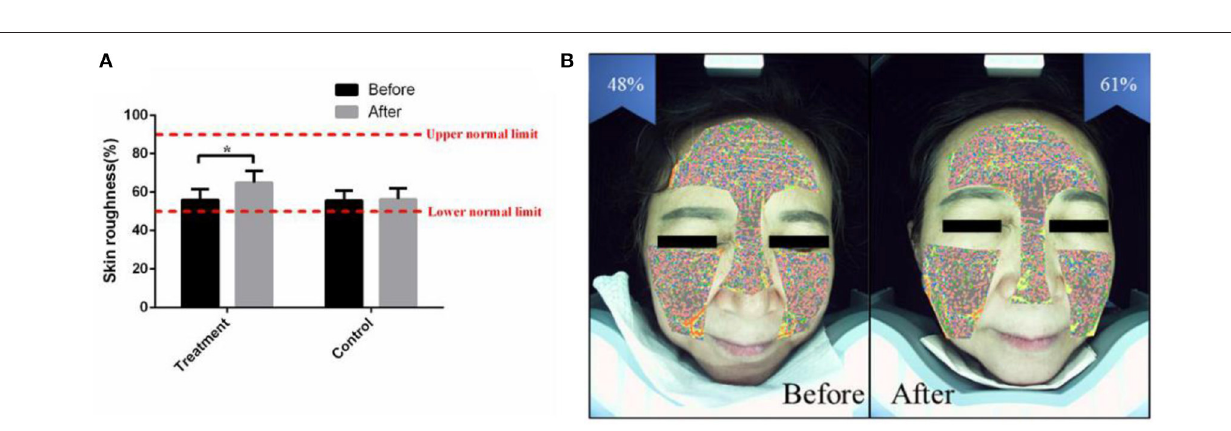
FIGURE 4 | The combined therapy rescued the skin roughness in the treatment group. (A) The average value of facial skin roughness (%) before and after treatment in the treatment group and control group. (B) Representative pictures of a 32-year-old female taken by intelligent facial detection in the treatment group, which shows the comparison between the values of facial skin roughness before and after treatment. The results are expressed as the mean ± SD. * p <